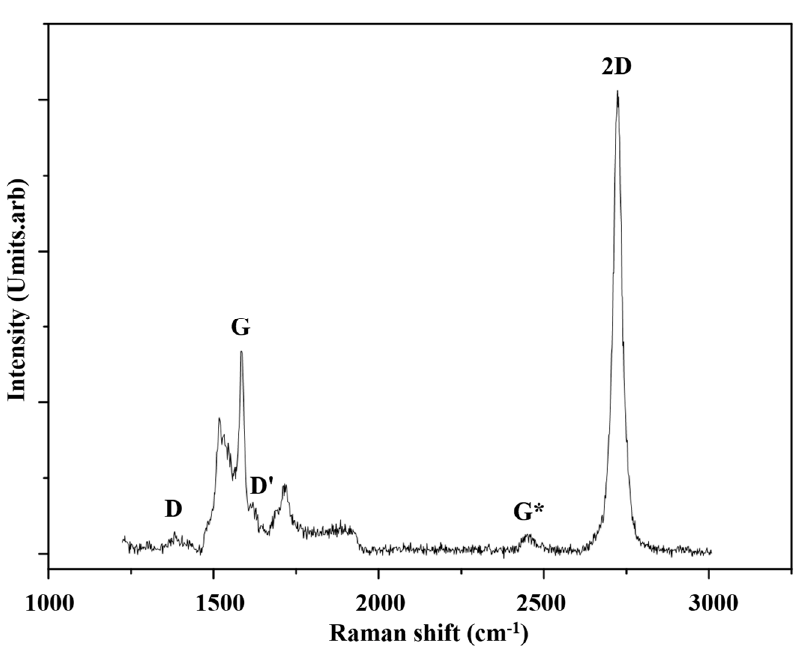
Figure 6. Typical Raman spectrum of a single layer of epitaxial graphene [16].